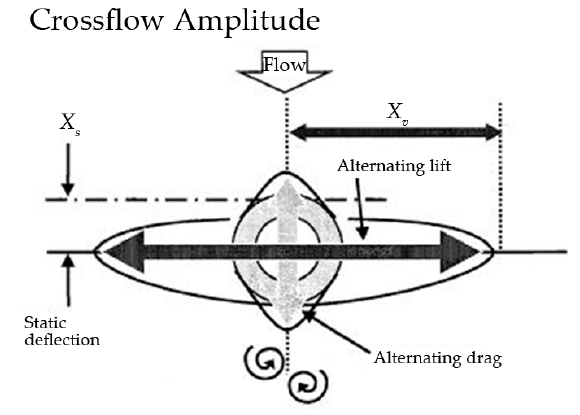
Figure 4. Mechanism of crossflow vibration amplitude.